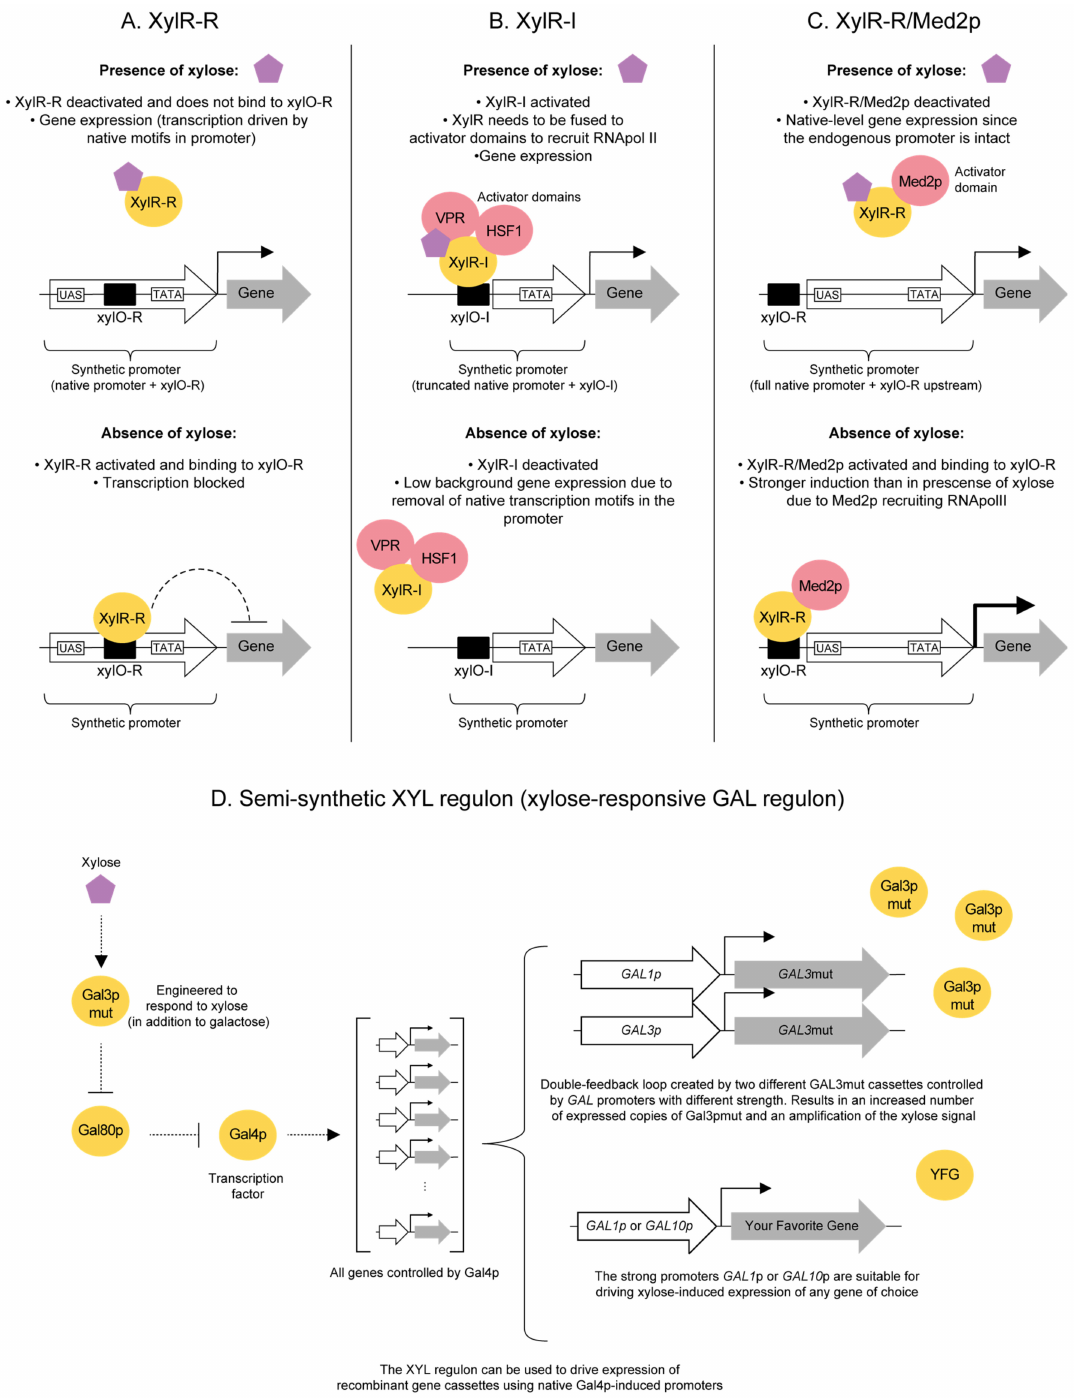
Figure 7. Schematic overview of strategies for synthetic D -xylose signaling circuits currently implemented in S. cerevisiae. ( A ) The repression-type XylR-R is used to block gene expression in the absence of D -xylose by binding to its operator xylO-R , which induces expression in the presence of D -xylose. Note that variations of the position of xylO-R in relation to the native elements can be used to tune the circuit strength [302]. ( B ) The yeast XylR-I strategy uses an E. coli activator-type XylR-I fused to activator domains. HSF1 is a mammalian heat shock factor 1 transactivation domain [308] and VPR is mammalian VP64-p65-Rta [309]. XylR-I is activated in the presence of D -xylose and binds to the xylO-I operator in the synthetic promoter and the activator domains recruit RNA polymerase II that initiates transcription. In the absence of D -xylose, XylR-I is inactivated and does not drive transcription. ( C ) The XylR-R/Med2p strategy combines elements from XylR-R and XylR-I by using a XylR-R fused to the Med2p activator domain. By positioning the xylO-R site upstream of the native